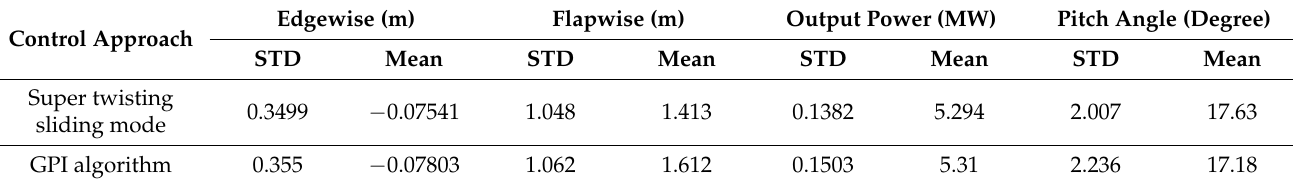
Table 4. Detailed simulation with mean wind speed = 20 m/s and turbulence intensity = 10%.